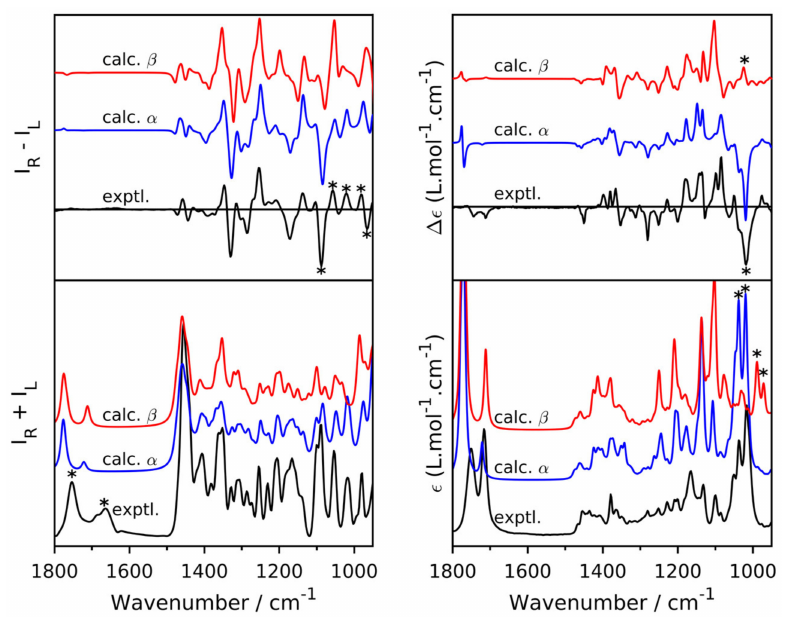
Figure 14. Comparison of experimental and calculated Raman/ROA ( Left ) and IR/VCD spectra ( right ) of artesunate. The asterisks (*) in the ROA, VCD and IR spectra indicate visual assignment to the α form. The (*) in the Raman spectrum (bottom left) indicate the typical overestimation of carbonyl stretch vibration in QM calculations. Reprinted with permission from ref. [58]. Copyright 2020 Royal Society of